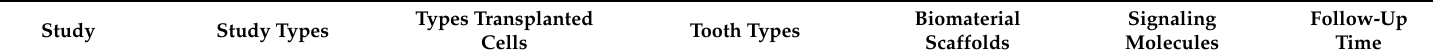
Table 2. Summary of the characteristics of the included clinical